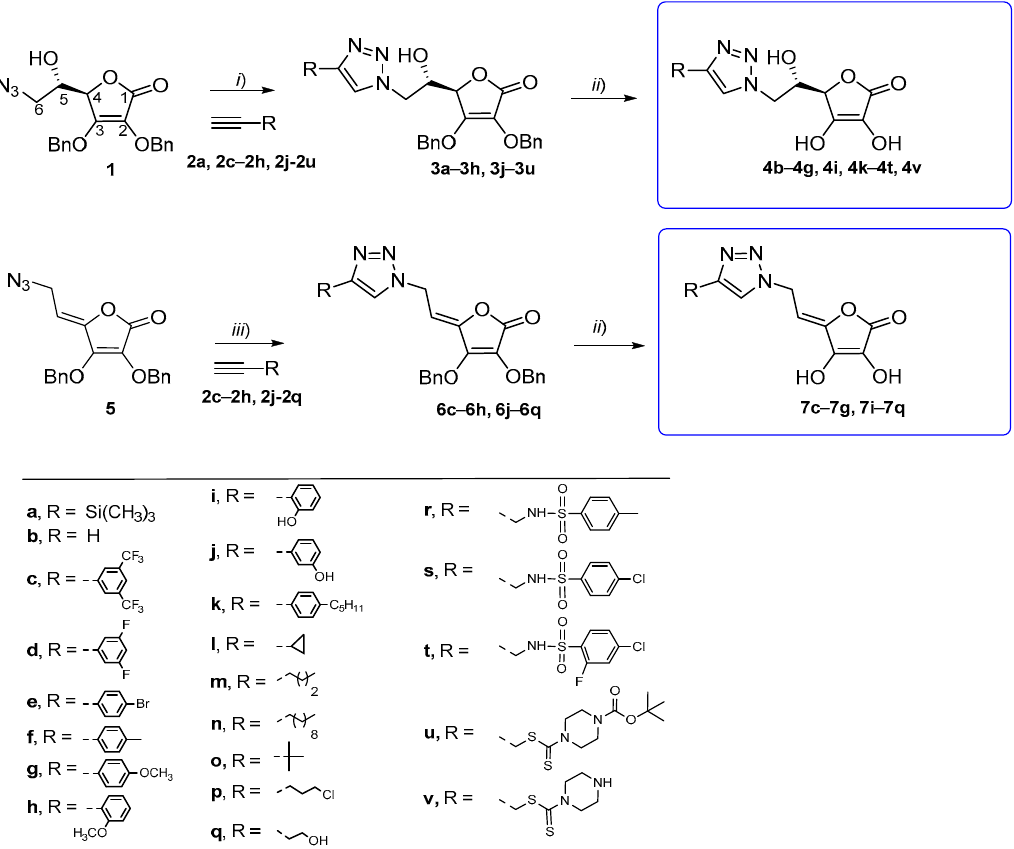
Table 1. The scavenging activity of L- ascorbic acid derivatives assessed by DPPH test. Results are presented as IC 50 values (mM) of DPPH • inhibition after 5 and 10 min